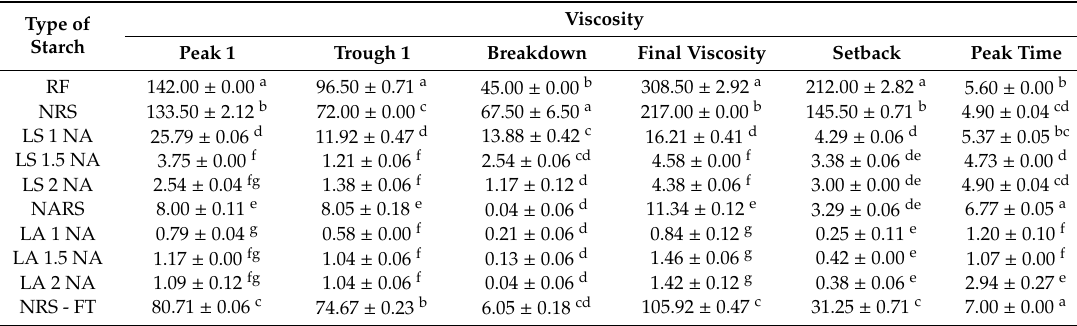
Table 4. Viscosity properties of the RD 31 rice flour, native starch, and modified